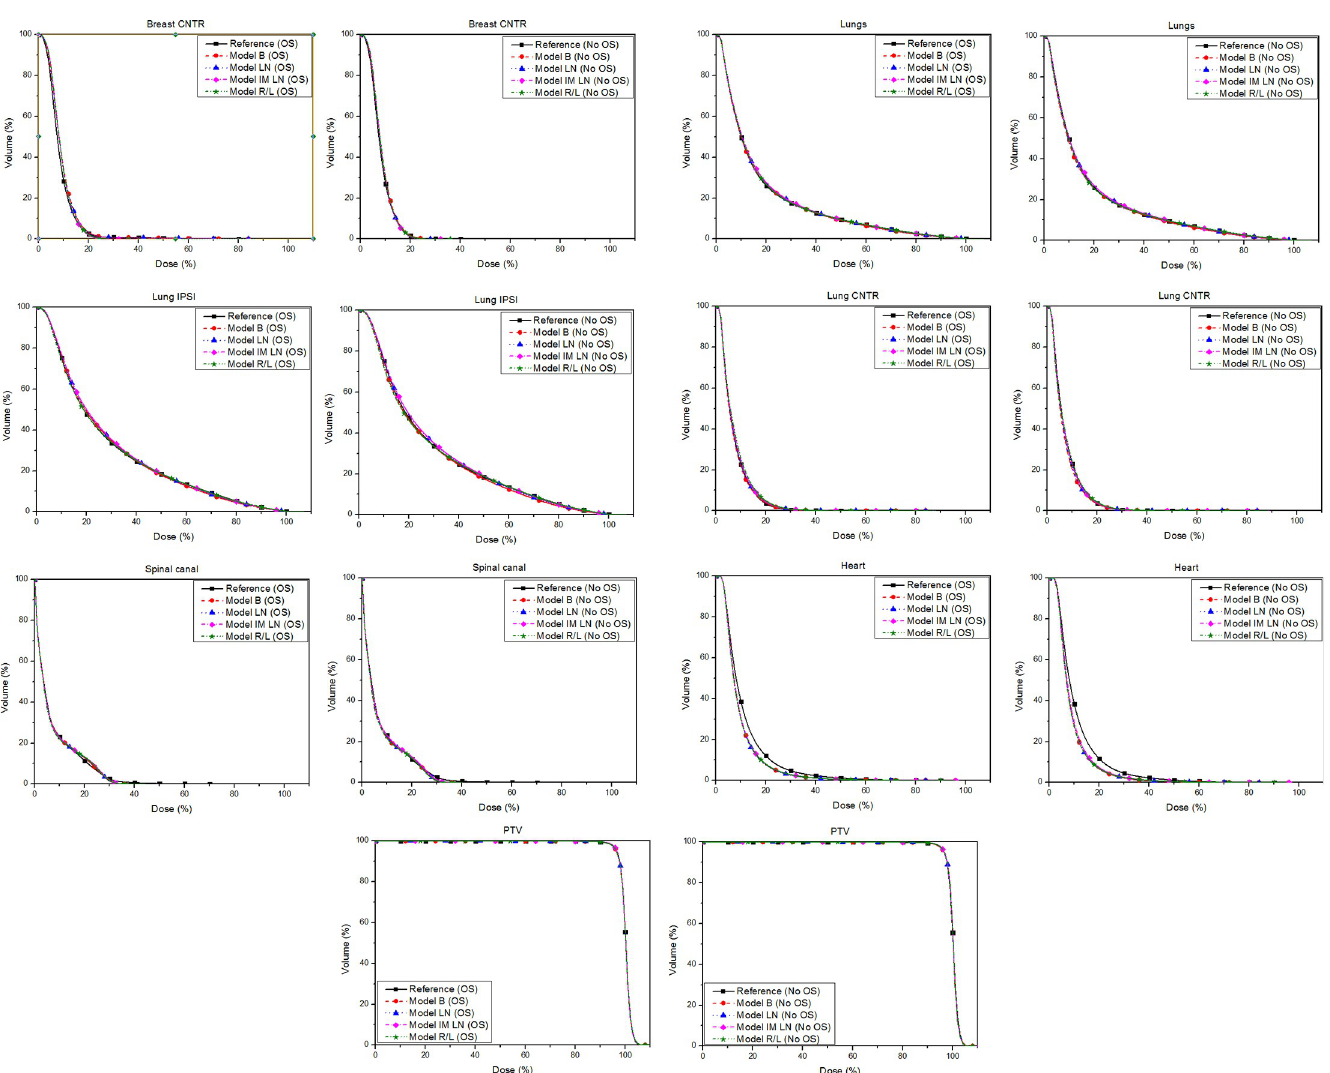
Fig 1. Average DVHs for the main OARs and the PTV of the 30 patients of the internal validation set. Comparison between Reference plan in black with the square symbol and model B in red with the round symbol, model LN in blue with the triangle symbol, model IM LN in magenta with the rhomboidal symbol and the sum of model R and L in green with the star